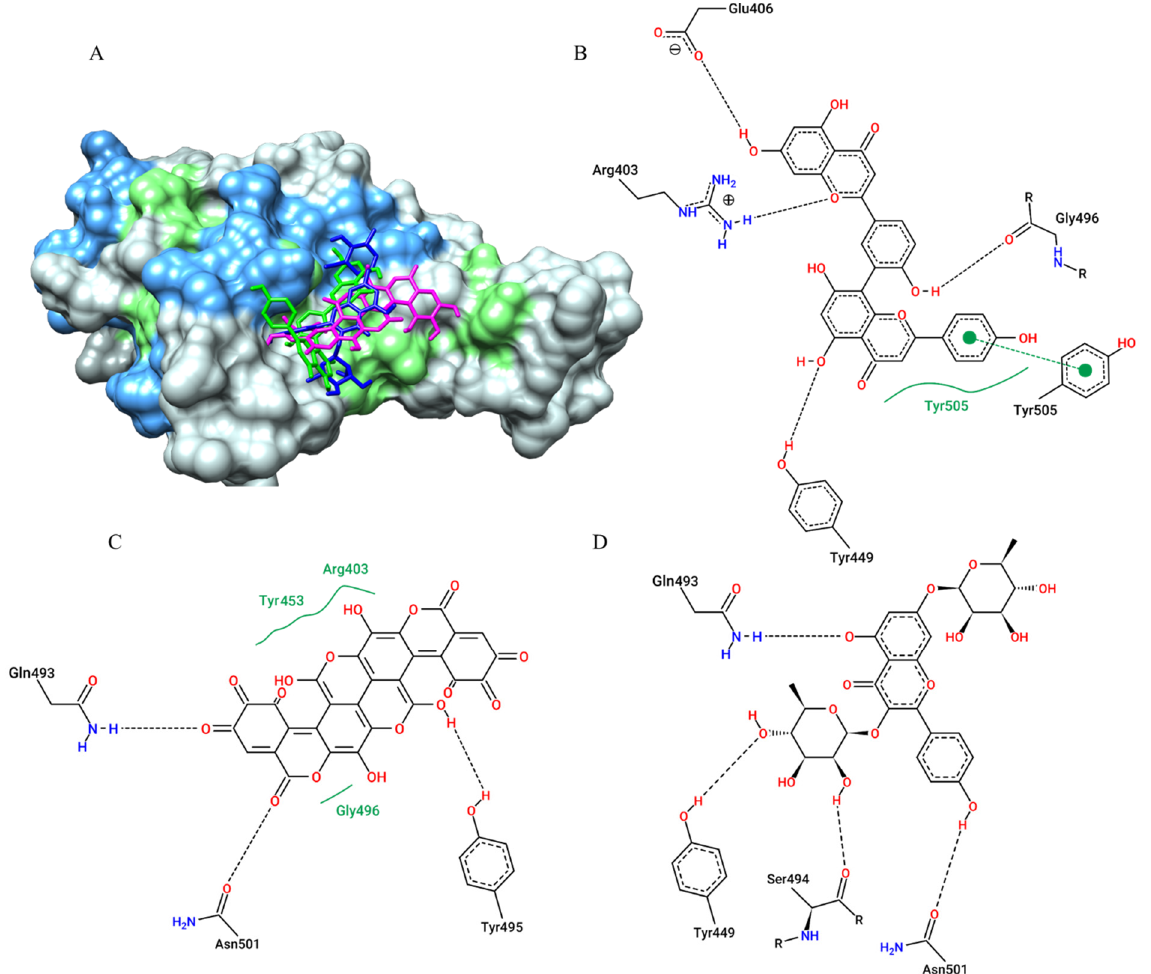
Figure 6. Surface representation of plant metabolites docking positions on the SARS-CoV-2 Spike protein (Spro) receptor-binding domain (RBD) active site, with amentoflavone (green), kaempferitrin (blue), and gallagic acid (magenta) ( A ). Contacts of SARS-CoV-2 Spike protein active site residues with amentoflavone ( B ), gallagic acid ( C ), and kaempferitrin ( D ) are depicted in a two-dimensional diagram. Dashed black lines represent hydrogen bonds, while full green lines represent van der Waals interactions, dashed green line represent π - π stacking.